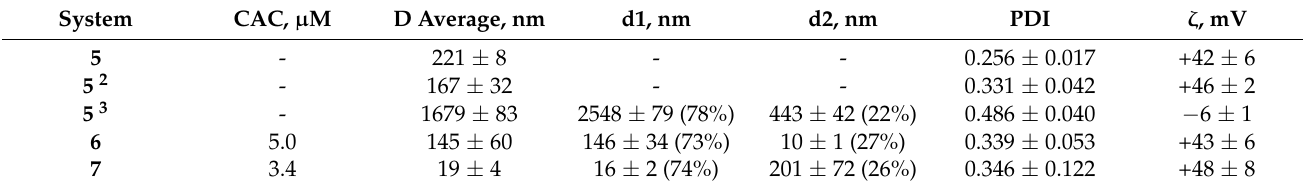
Table 1. DLS, ELS and CAC data for 5–7 solutions 1 .